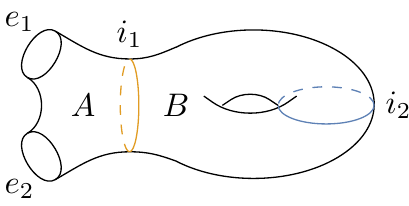
Figure 4 . A conformal block decomposition of the torus two-point function G kinematic parameters (cid:27) consist of a complex structure (cid:28) for the torus, and a separation w be- tween operators. We sum over representations in the internal cu(cid:11)s; for the yellow cu(cid:11) i 1 , this corresponds to the operators appearing in the OPE of external operators e 1 ; e 2 , and for the blue cu(cid:11) i 2 , an insertion of a complete set of states in the thermal